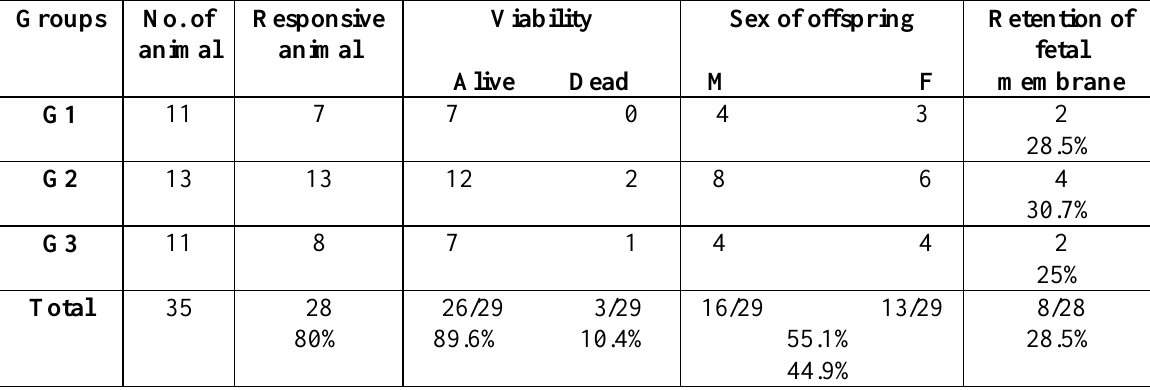
Table -2- showed the viability , sex of fetuses and retention of fetal membrane